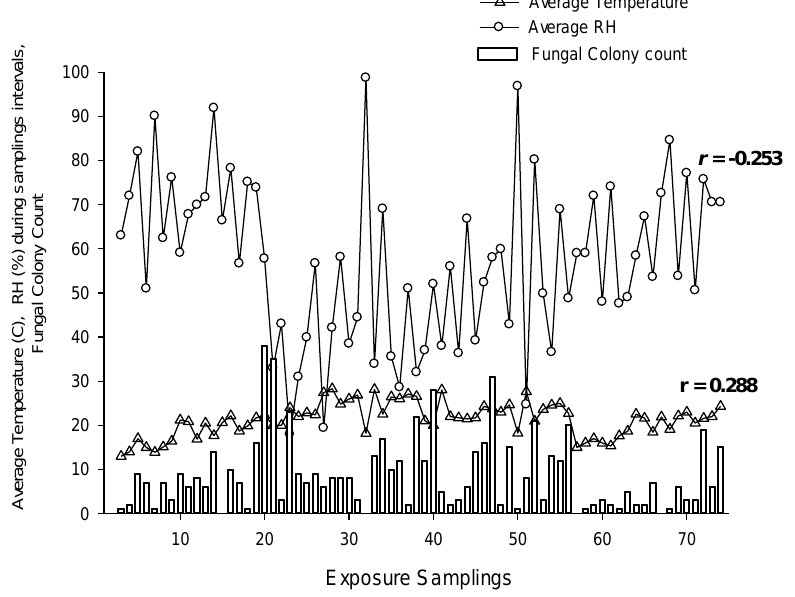
Figure 3. Variations in fungal colony counts in each exposure sampling with respect to changes in average temperature and relative humidity (RH) during the 6 h intervals. Correlation coefficient values ( r ) are significantly different between mean daily counts and mean daily temperature and mean daily relative humidity at p ≤ 0.05, according to Pearson’s correlation coefficient.